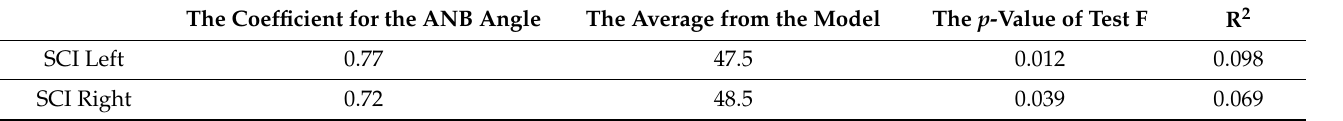
Table 5. The linear regression